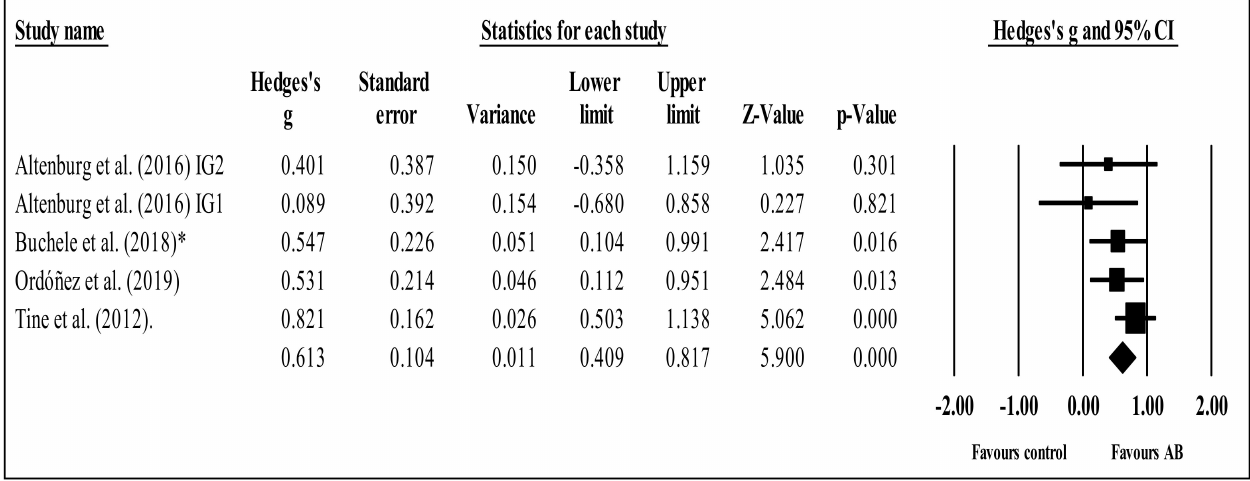
Figure 4. Forest plot of changes in selective attention in school-age students participating in active breaks (AB) compared to controls. Values shown are effect sizes (Hedges’ g) with 95% confidence intervals (CI). The size of the plotted squares reflects the statistical weight of each study. The black diamond reflects the overall result. This is a statistically significant result. IG: intervention group. * Critical risk in ROBINS-I.